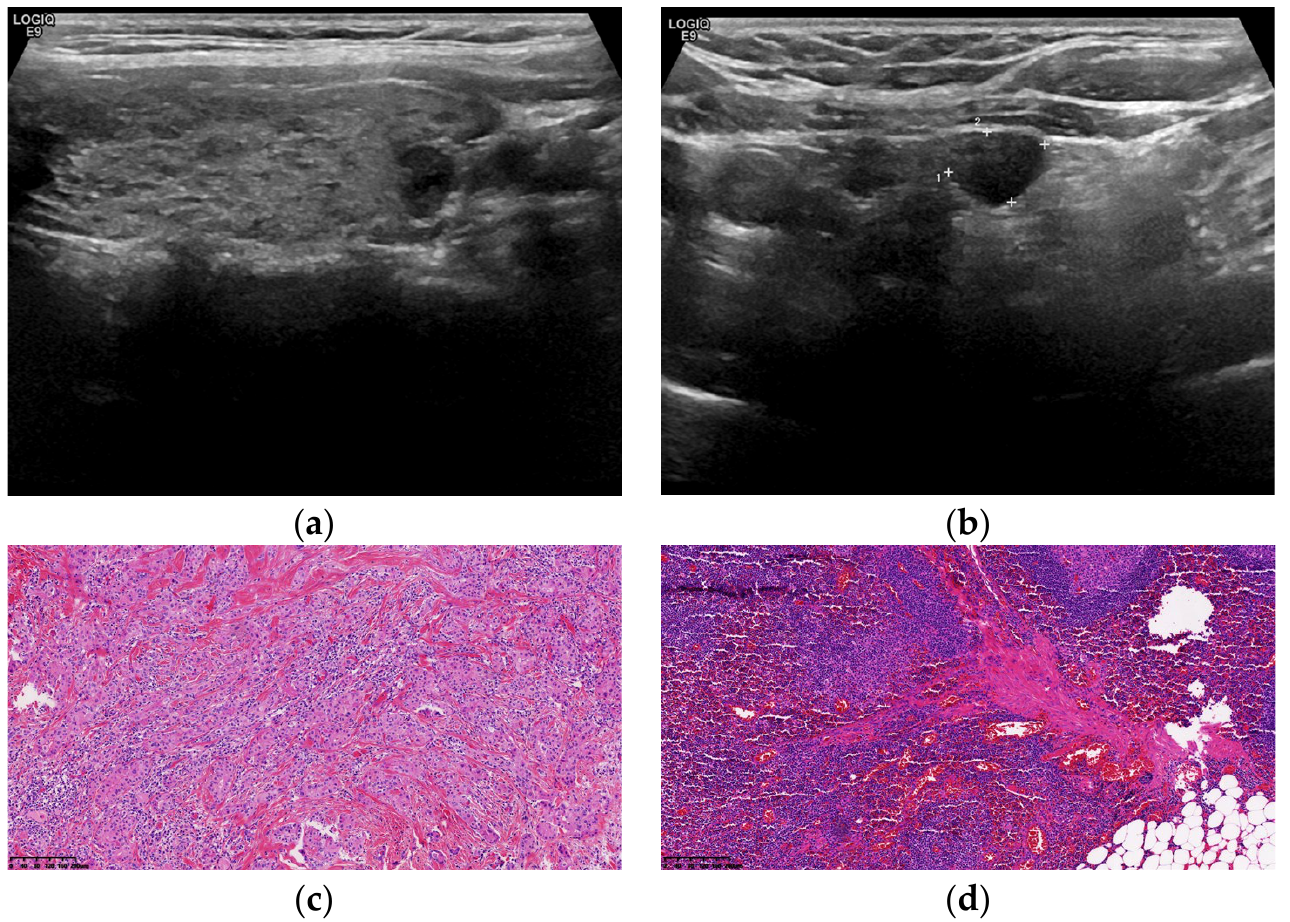
Figure 4. A 35-year-old female patient with a preoperative serum Tg of 2.31 ng/mL. Ultrasound findings: thyroid left lower lobe nodule, TI-RADS 5 categories ( a ) Left cervical lymph node enlarge- ment, suspicious metastatic lymph nodes ( b ) Postoperative pathology shows papillary thyroid mi- crocarcinoma ( c ) shows haematoxylin and eosin [HE] staining, magnification ×100). Left cervical lymph node chronic inflammation ( d ) shows HE staining, magnification ×100). Tg, serum thy-